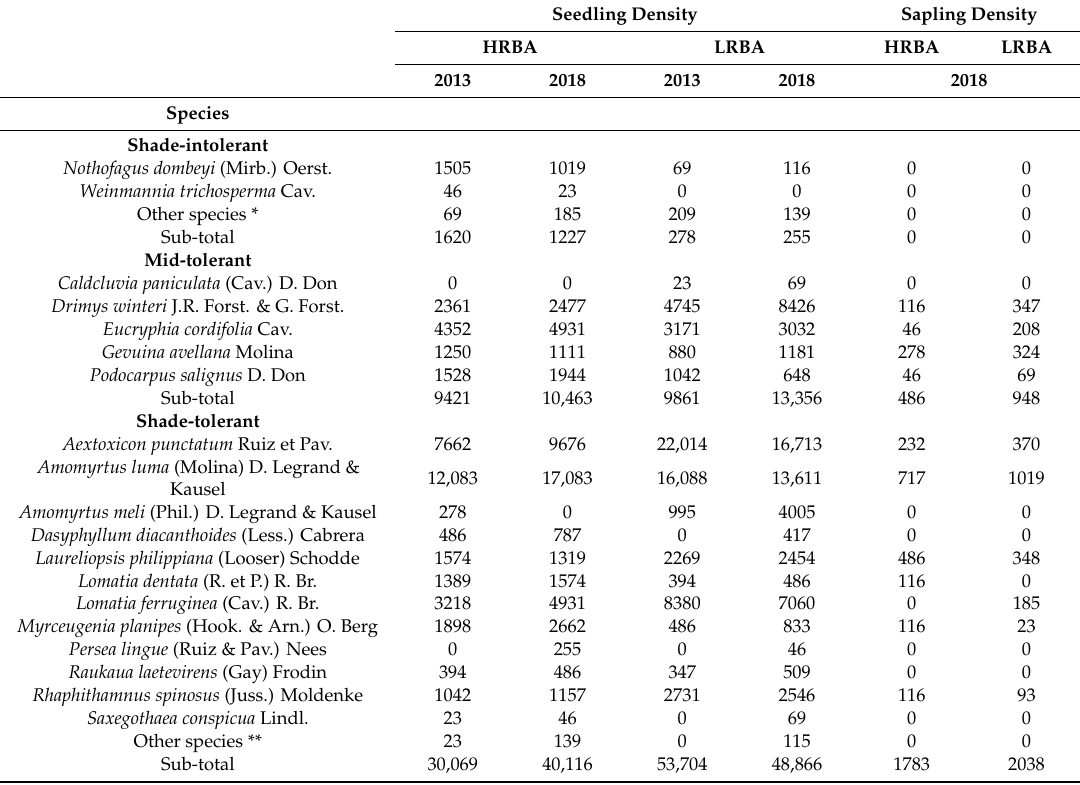
Table 1. Mean of the regeneration density (per ha values) of seedlings and saplings according to species and treatment (HRBA and LRBA) in Llancahue (LL) following the cuts (2013) and five years after the cuts (2018). Table S7 in the Supplementary Materials provides both the mean and standard